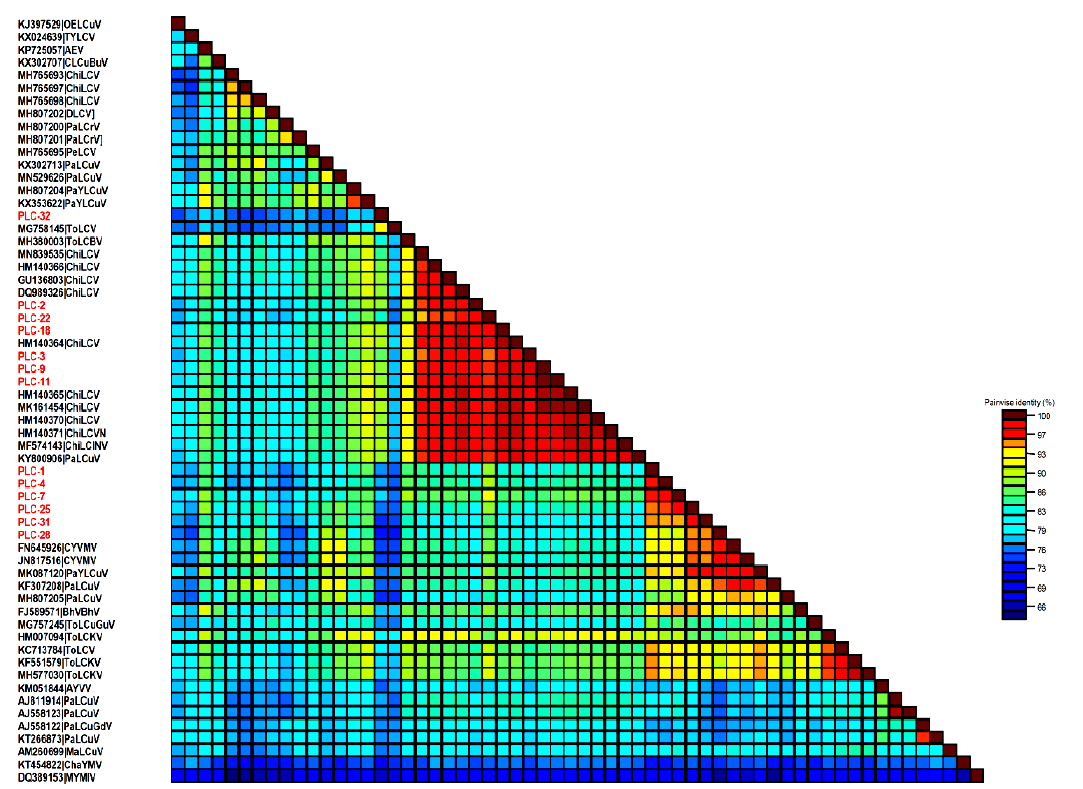
Figure 3. Graphical representation of per cent pair wise genome scores and nucleotide identity plot of full-length genome of DNA-A component of isolated begomoviruses from papaya with other begomoviruses [Prepared using the SDTv1.2 (Species Demarcation Toll)]. Table 2. Maximum percentage nucleotide sequence identity of DNA-A component of begomoviruses isolated from papaya with other known begomovirus isolates and assigning acronyms to the isolates.